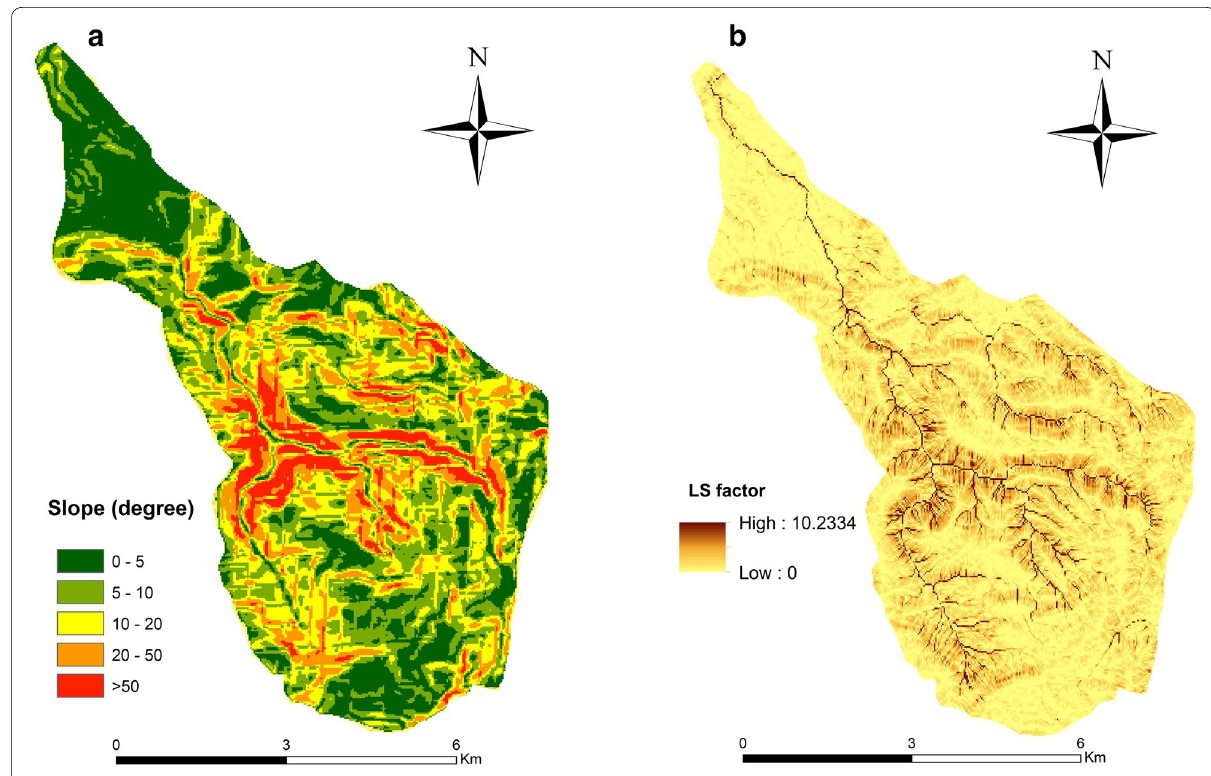
Fig. 5 Slope ( a ) and LS-factor ( b )